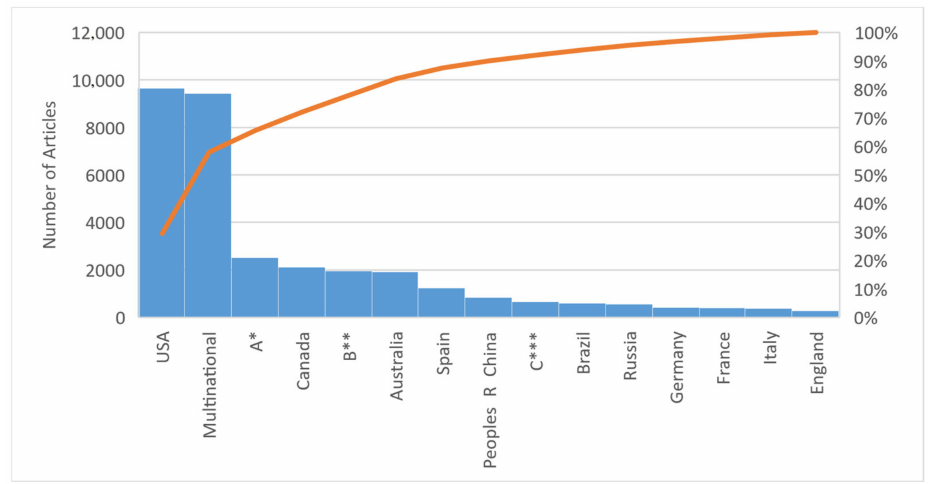
Figure 2. Number of articles by country. A * for countries which have publications between 500 and 999, B ** for countries which have publications between 100 and 499, and C *** for other countries having fewer than 100